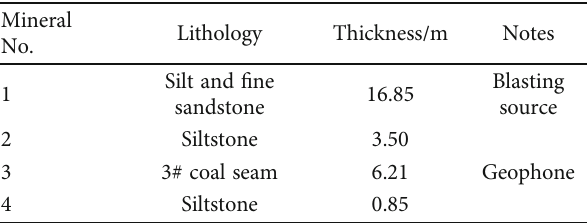
Table 3: Distribution of strata in the testing area. Mineral